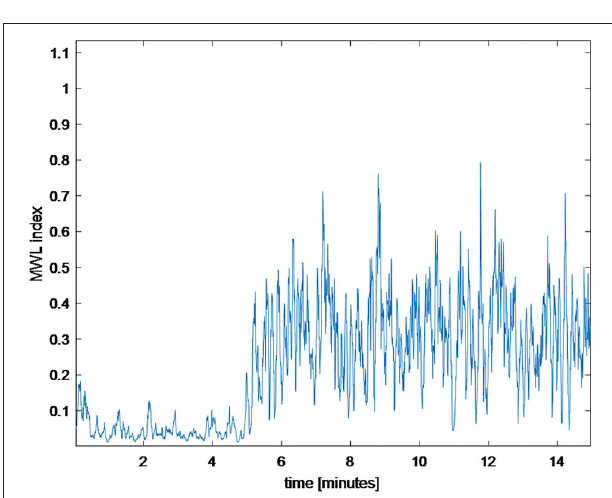
FIGURE 9 | MWL index of the first 15min of the experiment (window size is